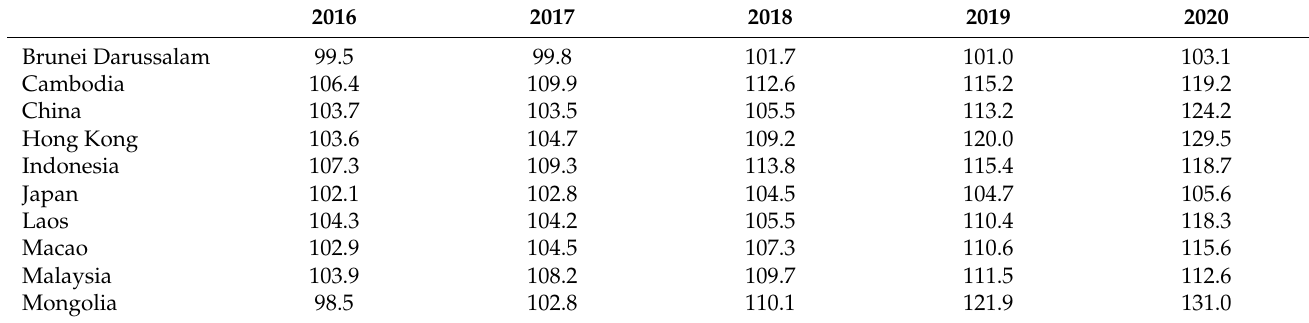
Table 6. CPI for food in East and Southeast Asian economies. Base year (2015) =